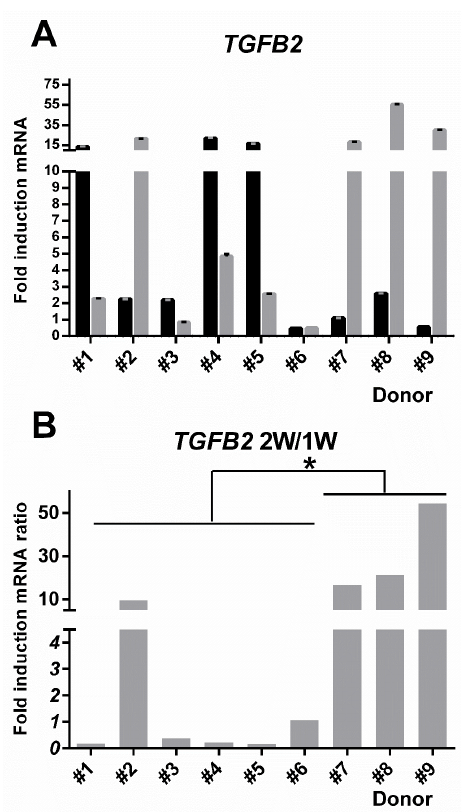
Figure 8. Inter-donor heterogeneity for fold increase in TGFB2 gene induction versus corresponding non-induced hMSC control cells derived from donors #1–#9. ( A ) Gene upregulation in response to osteogenic medium treatment for one week (1 W) (black bars) or two weeks (2 W) (grey bars). Error bars indicate the pooled coefficient of variation. ( B ) The fold-induction ratio for values at one or two weeks post induction. Interpolation used the GUSB / YWAHZ reference gene pair. Independent t-test between hBM-MSC and hAT-MSC groups * p < 0.05.